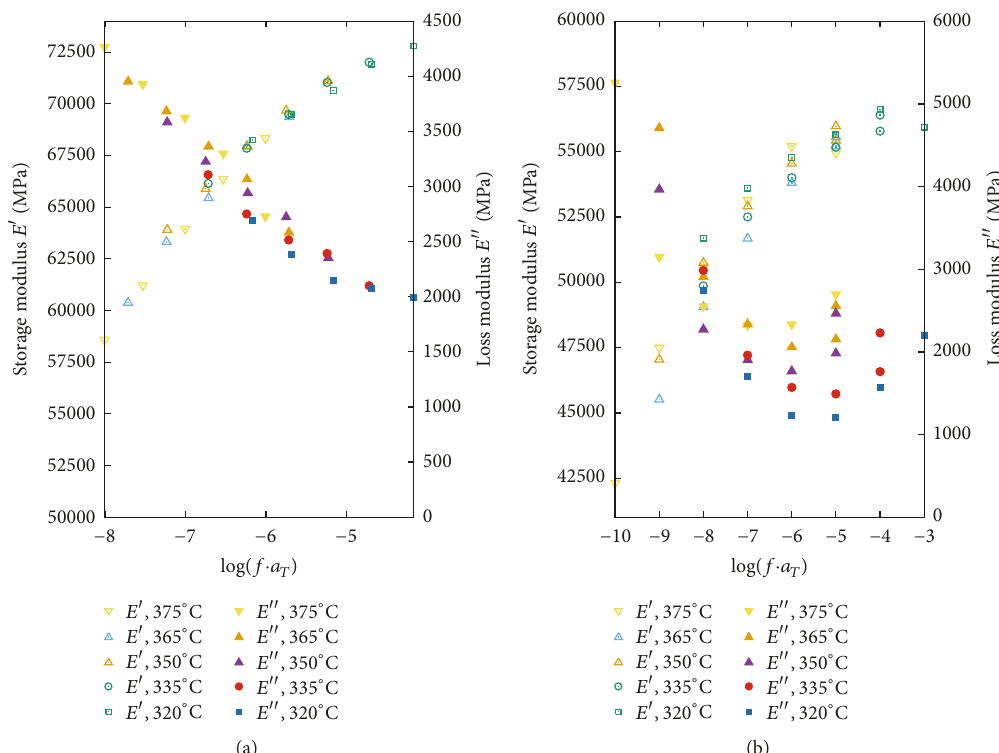
Figure 8: Master curves showing the storage modulus 𝐸 󸀠 (hollow symbols) and the loss modulus 𝐸 󸀠󸀠 (solid-fill symbols) versus the logarithm of the frequency 𝑓 times the shift factor 𝑎 𝑇 . These curves resulted from horizontal shifting of the isothermal curves of 𝐸 󸀠 and 𝐸 󸀠󸀠 from DMA tests on AA 2024-T3 (a) and solution treated AA 2024 (b), from 320 to 375 ∘ C.